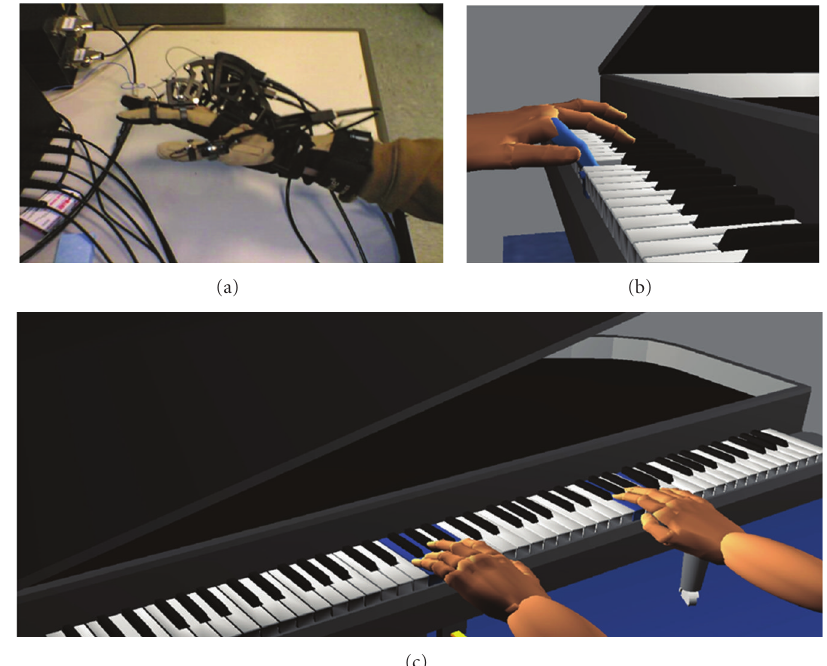
Figure 18: Virtual Reality Piano. (a) CyberGrasp worn over a CyberGlove. (b) A virtual key press. (c) Piano simulation with hands shown in a first-person perspective. Reprinted with permission.